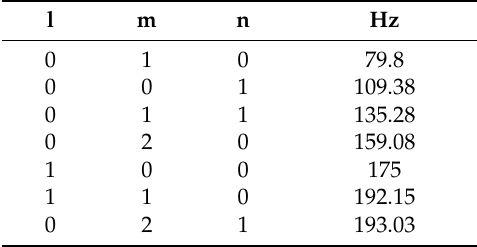
excitation 79.7 Hz. ( a ) p 1 ( t ) , ( b ) p 2 ( t ) , and ( c ) q ( t )